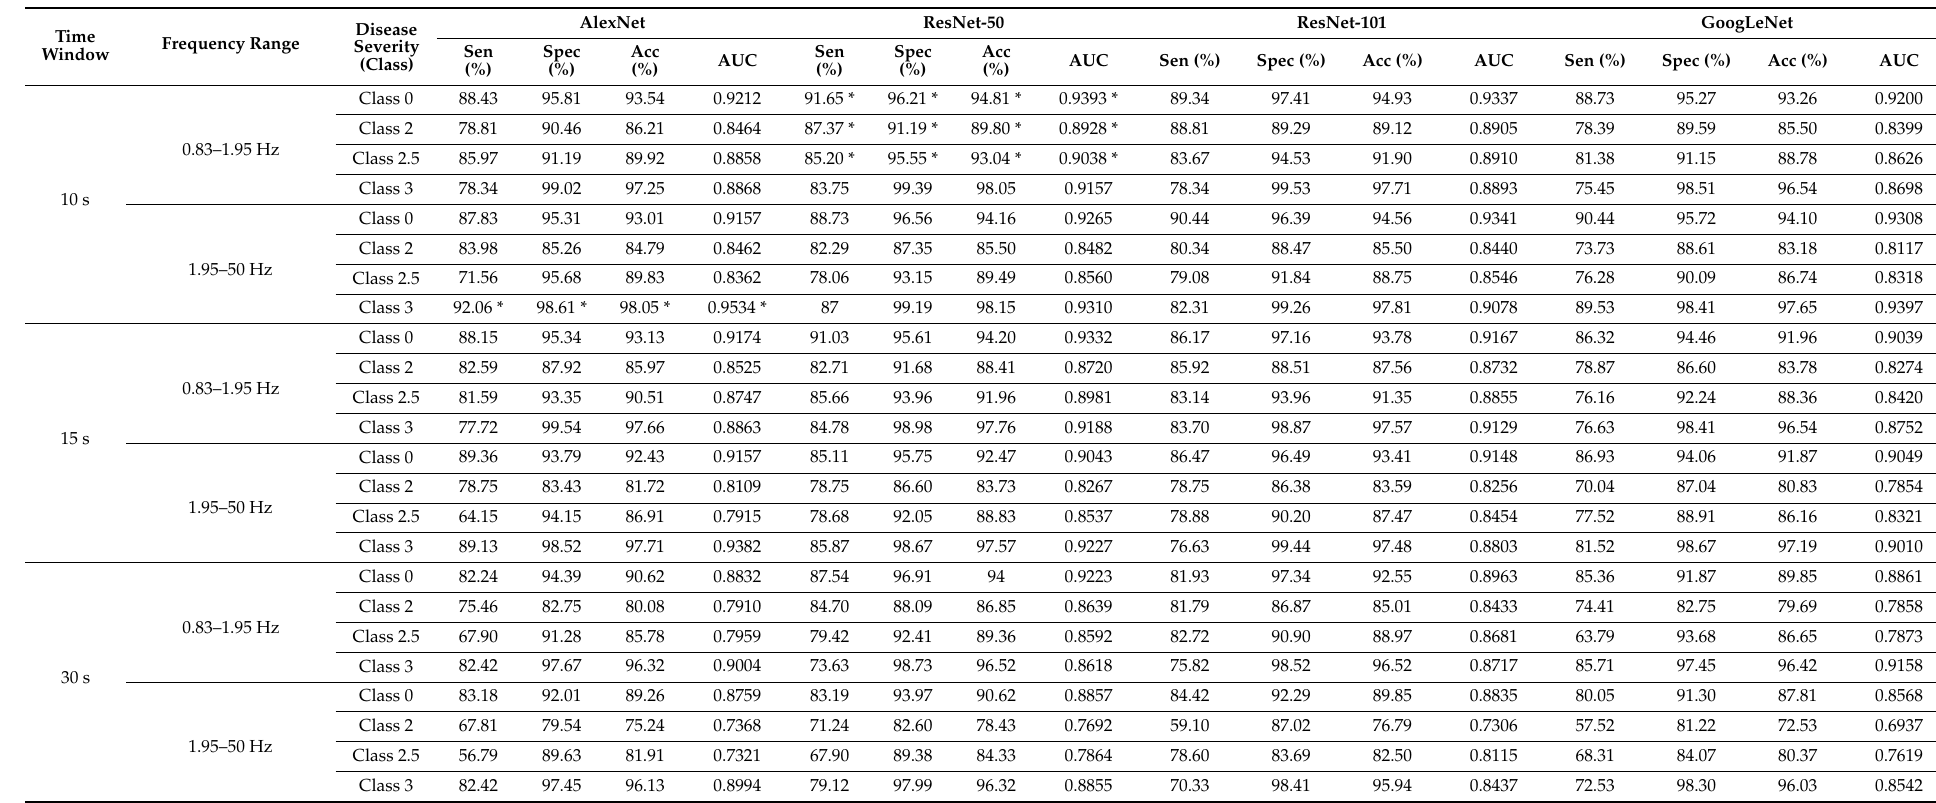
Table 16. Multi-class classification of CF from all datasets for CO (Class 0), PD Stage 2 (Class 2), PD Stage 2.5 (Class 2.5), and PD Stage 3 (Class 3) using several CNN classifiers (AlexNet, ResNet-50, ResNet-101, and GoogLeNet) with 10-fold